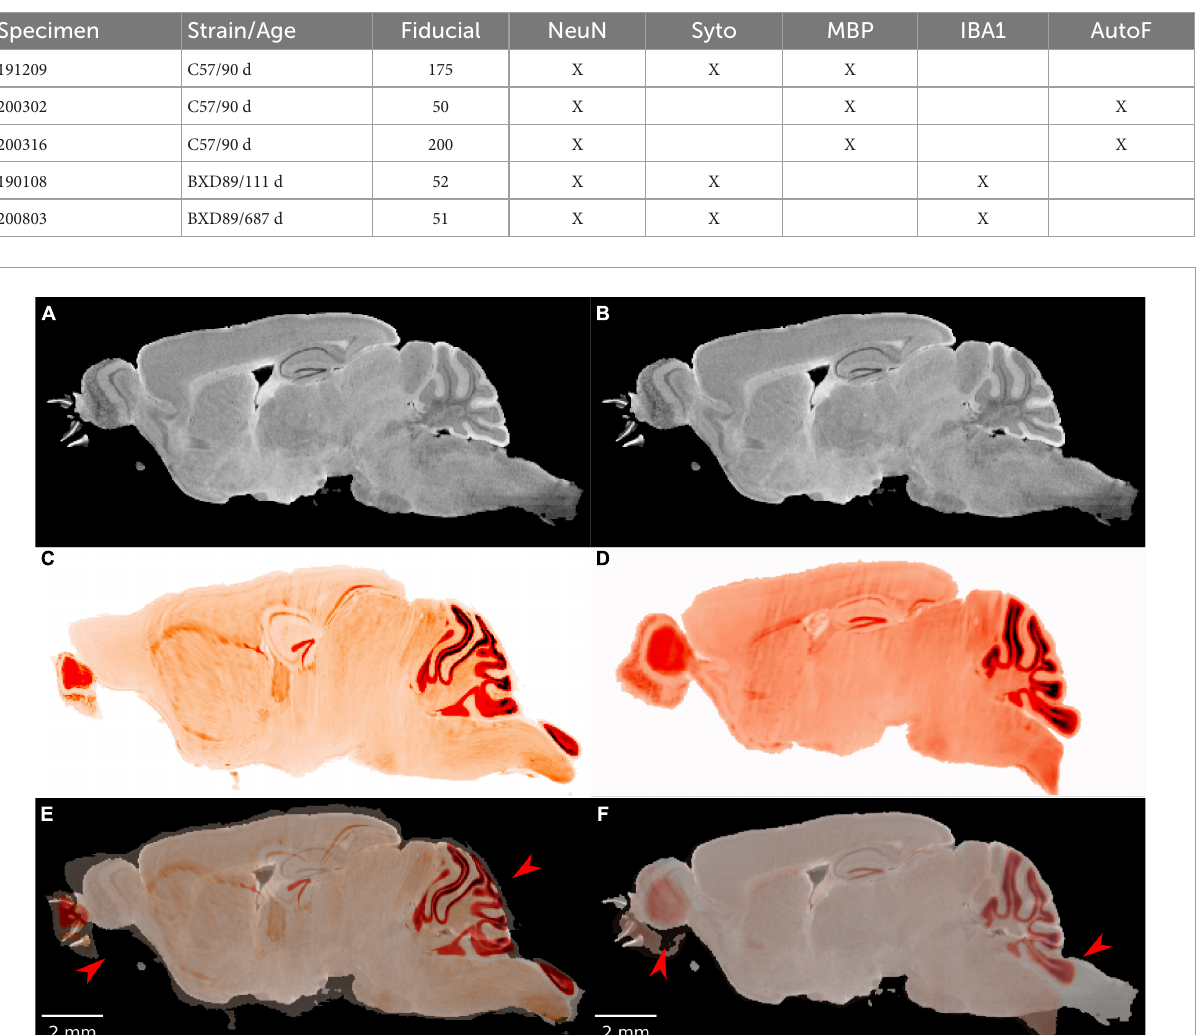
TABLE 1 Test specimens for combined magnetic resonance histology (MRH)/light sheet microscopy (LSM) registration.